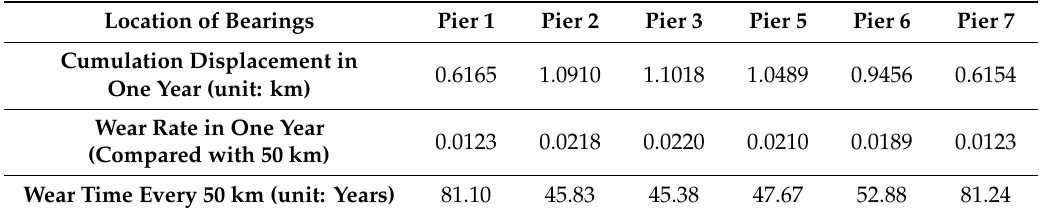
Table 1. Cumulative longitudinal displacement and wear details of the bridge